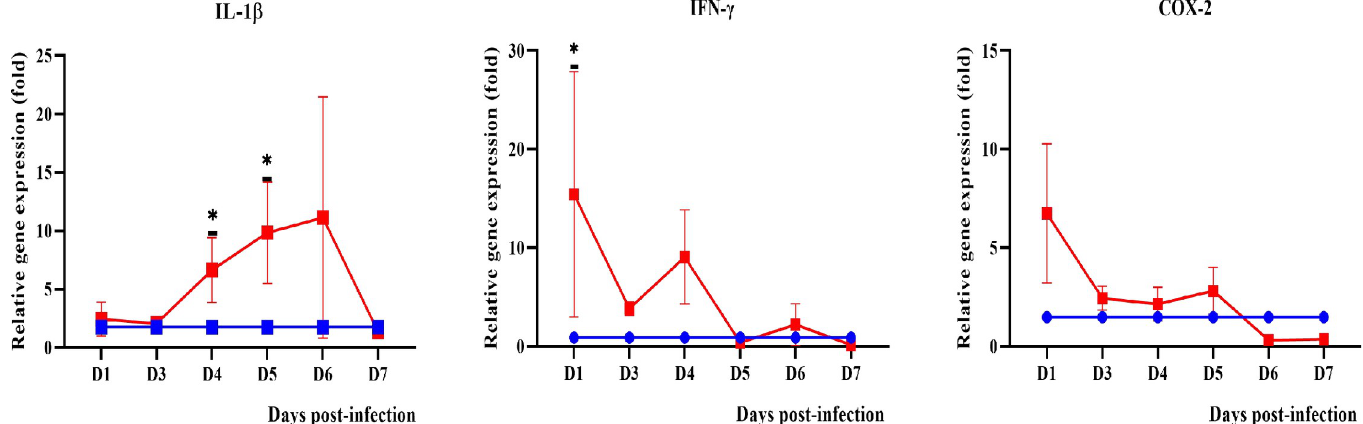
Fig 9. Modulation of pro-inflammatory cytokines and enzyme in the blood of control (blue line) and infected hamsters (red line). Total RNA was extracted from whole blood on day 1 and days 3 to 7 p.i.. D1-D7: Day 1 to day 7. � P � 0.05. The fold gene expression value can be found in S2 Table.